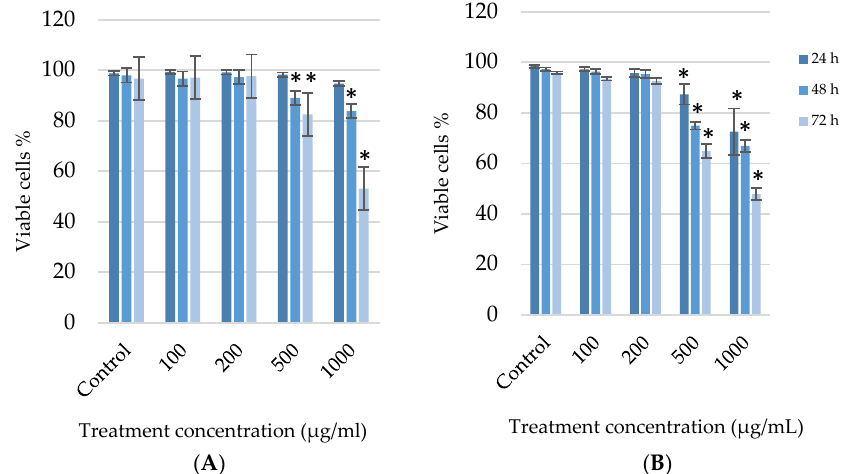
Figure 2. After the human melanoma (A375) cells ( A ) and normal human skin (HaCaT) cells ( B ) were treated with 100; 200; 500 and 1000 µg/mL concentrations of G. africana ethanolic extract for 24, 48 and 72 h, the cell proliferation and viability was determined using trypan blue exclusion assay. Data represent the mean ± SD, n = 3, where the * indicates statistical significance at level p < 0.05 vs. the control.